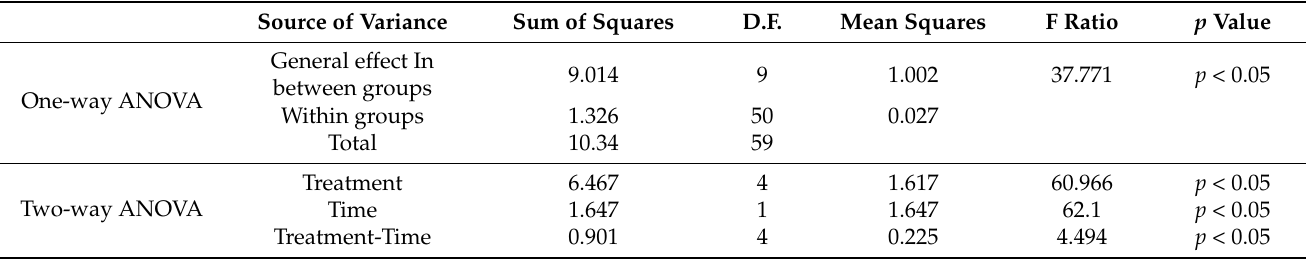
Table 1. Effect of treatment, time and their interactions on paw circumference in rats (one-way and two-way